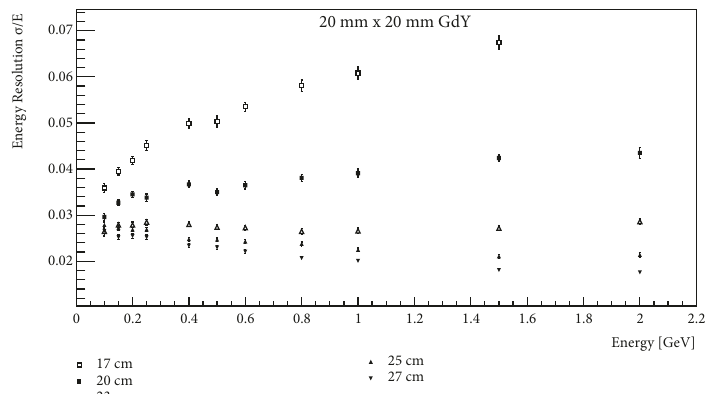
Figure 2: Energy resolutions as a function of beam energy for GdY with 20 mm x 20 mm back face area and five different thicknesses.